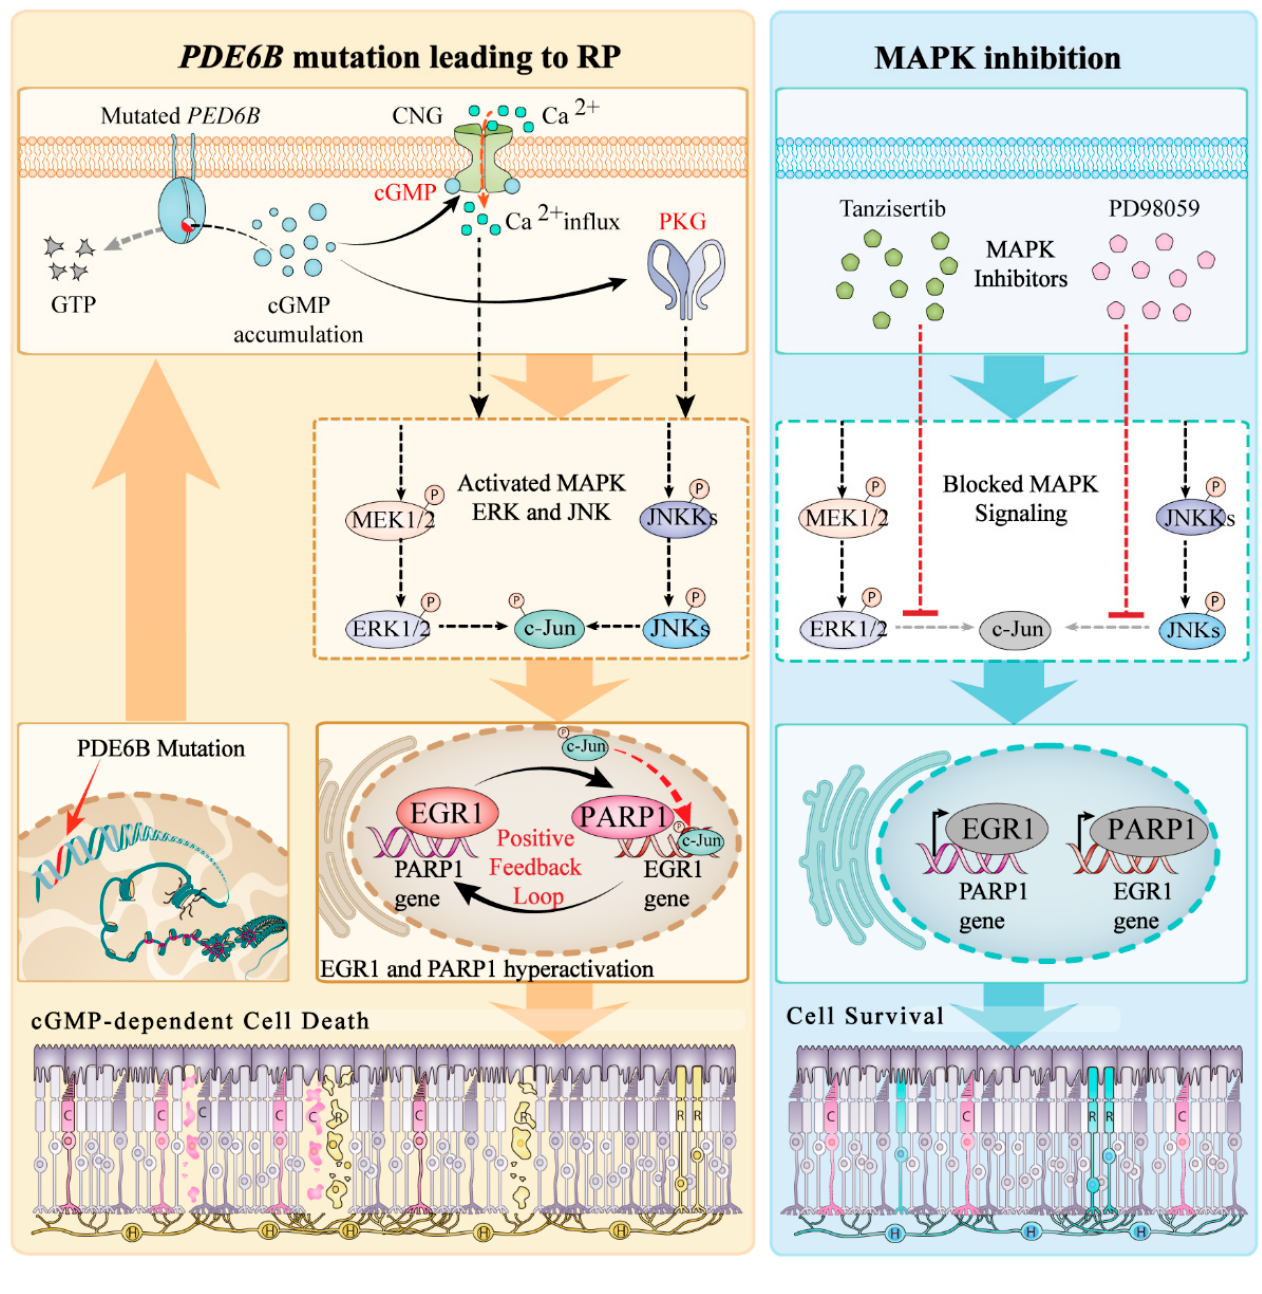
Figure 8. Role of EGR1 and MAPK signaling in photoreceptor cell death. ( Left ) Disease-causing mutations in the PDE6B gene induce photoreceptor cGMP accumulation. This in turn activates cyclic nucleotide gated (CNG) channels in the outer segment, leading to Na + -and Ca 2+ -influx, photoreceptor depolarization, and parallel activation of protein kinase G (PKG). Further downstream, MAPK, ERK, and JNK signaling pathways are activated, likely causing c-Jun to translocate to the nucleus and promoting EGR1 expression. This may drive a positive feedback loop with EGR1 and PAPR1 as core molecules, expressing a large amount of EGR1 protein to bind to the PARP1 gene promoter region, further stimulating its transcription and causing photoreceptor cell death. ( Right ) Inhibition of c-Jun nuclear translocation with either tanzisertib or PD98059 can reduce the expression of EGR1 and PARP1, thereby delaying cell death.